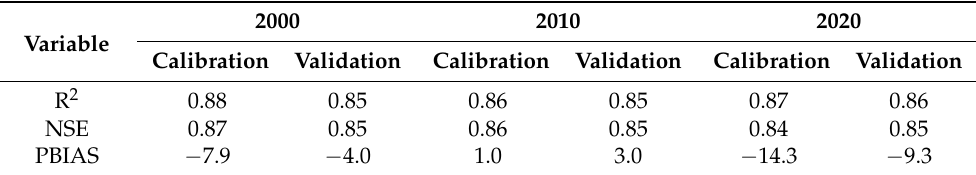
Table 2. Statistical performance indicators during calibration and validation LULC